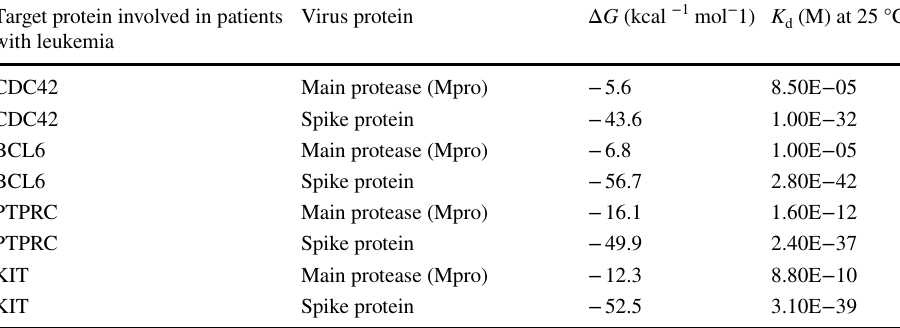
Table 3 Docking results of the hub proteins of leukemia and the key proteins of SARS- CoV-2